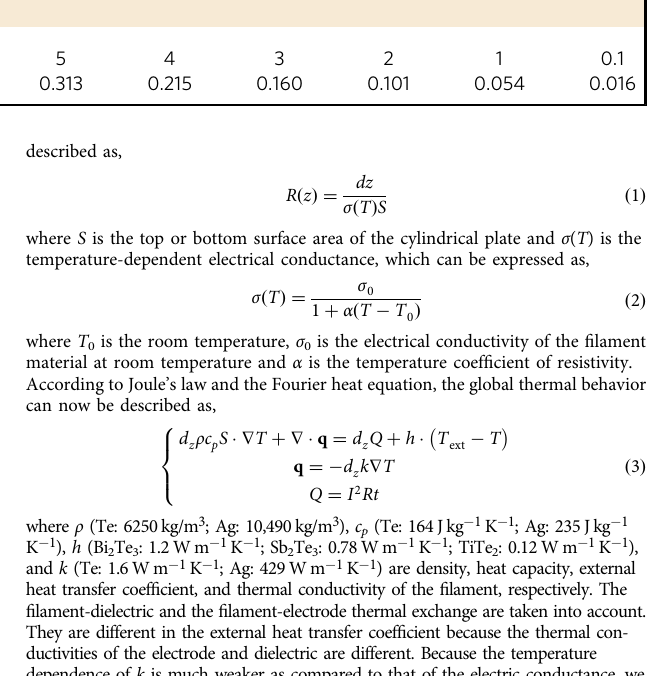
Table 1 Δ w versus pulse